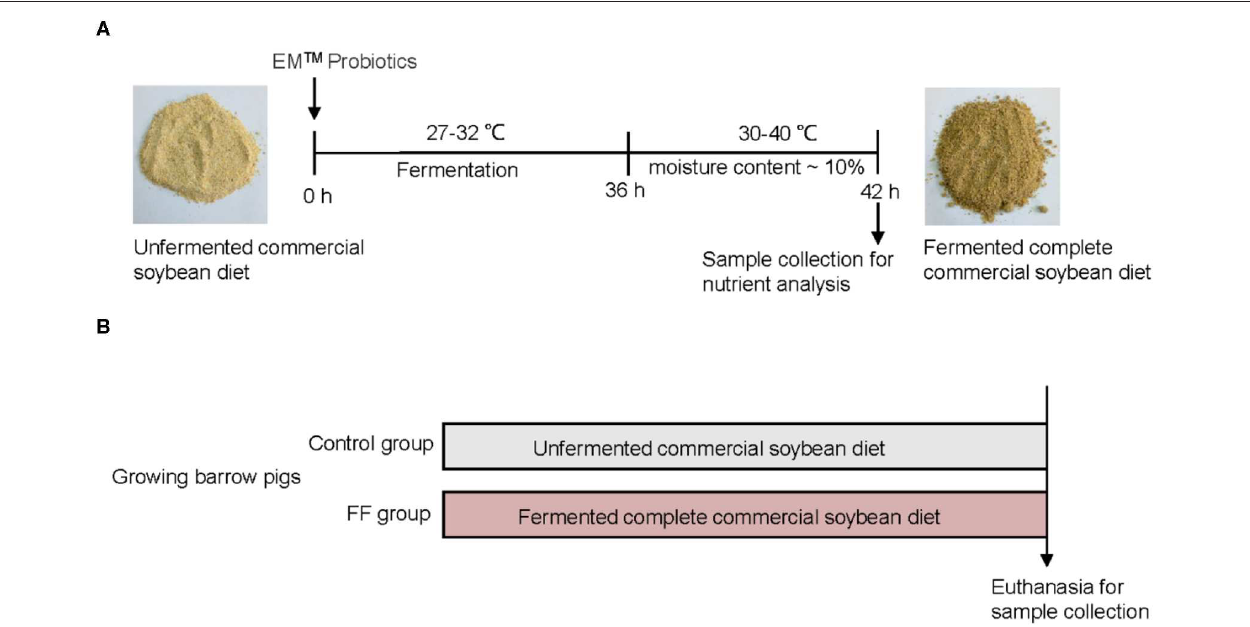
FIGURE 1 | Experimental design. (A) Preparation and composition of FF. (B) Experimental design.